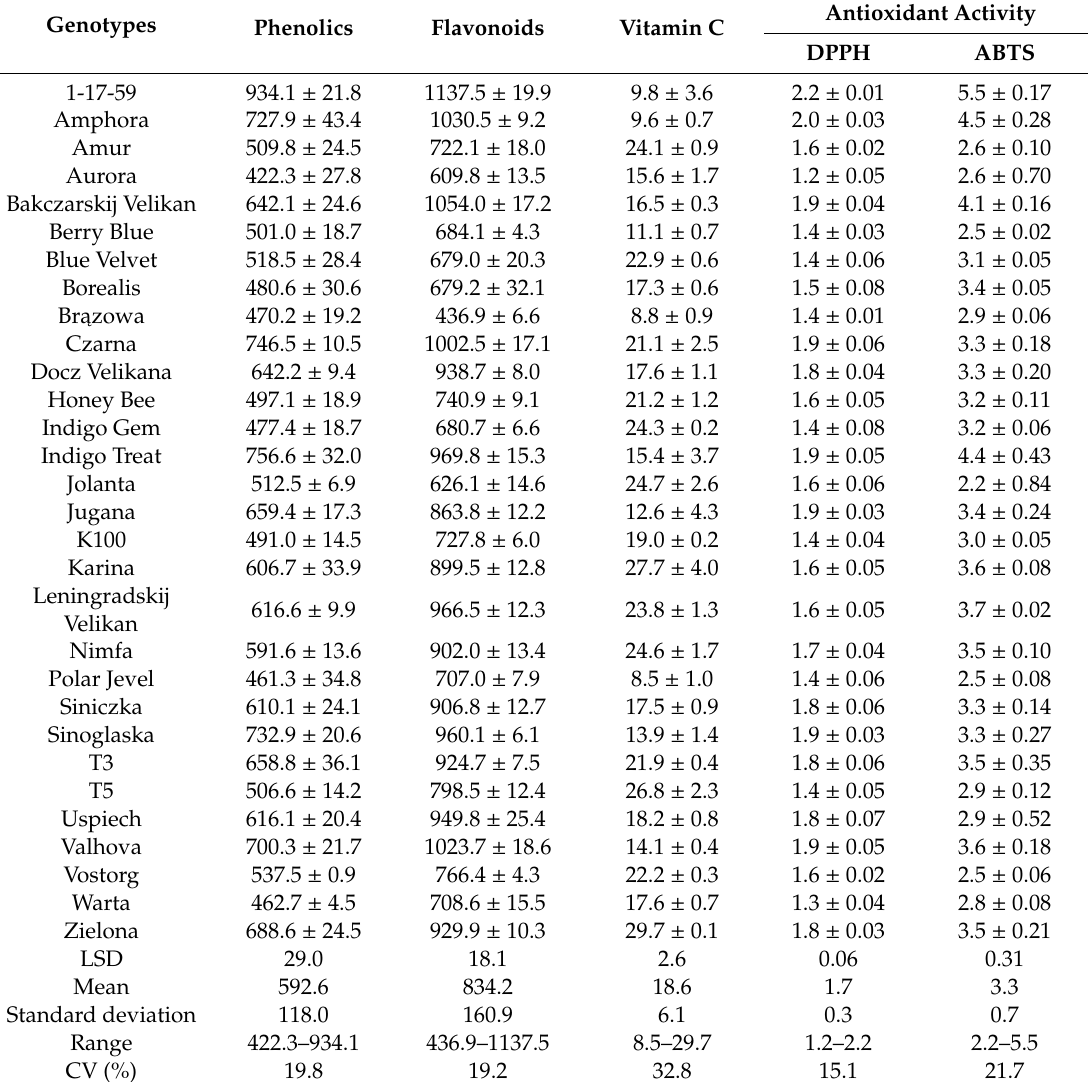
Table 2. Total phenolics, flavonoids, vitamin C content and antioxidant activity determined by the DPPH (1,1-diphenyl-2-picrylhydrazyl) and ABTS (2,2 (cid:48) -azino-bis(3-ethylbenzothiazoline-6-sulfonic acid) assays in fruits of 30 genotypes of blue honeysuckle. The results are given in mg gallic